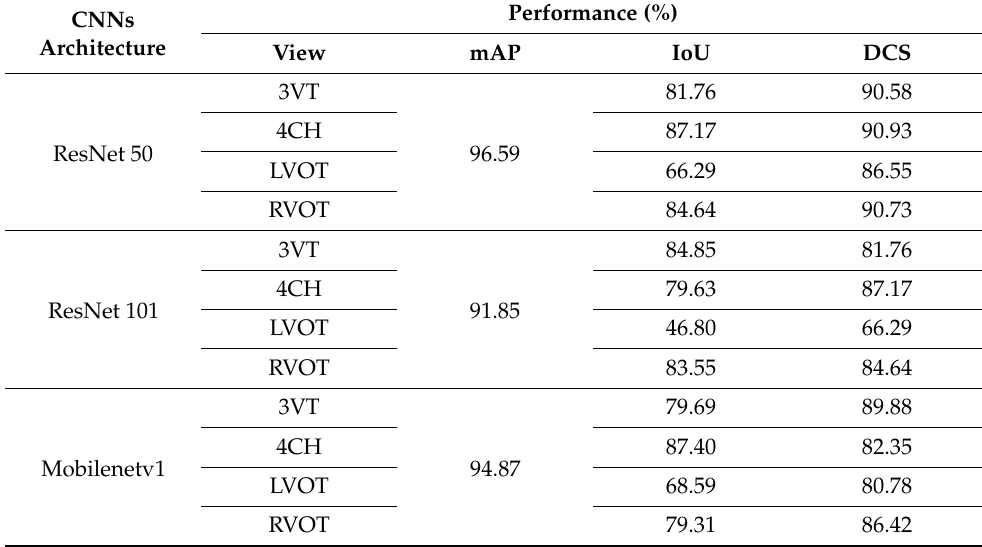
Table 4. The performance of fetal heart standard